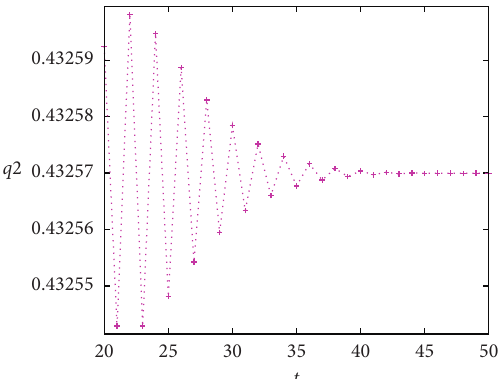
Figure 15: The quantity fluctuations of manufacturer 2.